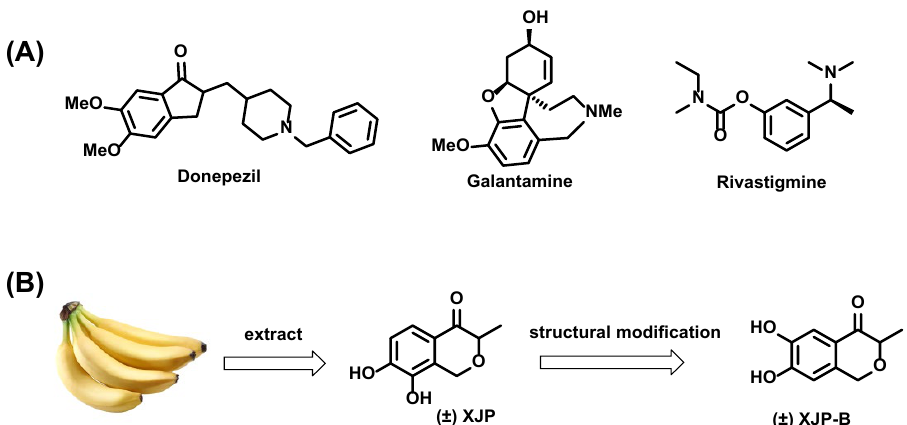
Figure 1. ( A ) The structures of AChE inhibitors donepezil, galantamine and rivastigmine; ( B ) The structure of (±)-XJP and (±)-XJP-B.